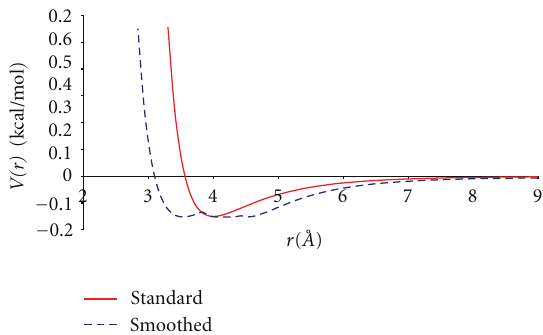
Figure 3: Representation of the real (standard) and the soft (smoothed) van der Waals potential used in this work. Soft potential has the e ff ect of widening the region of maximum a ffi nity at ε and also reduces the potential energy at r = 0 to a finite